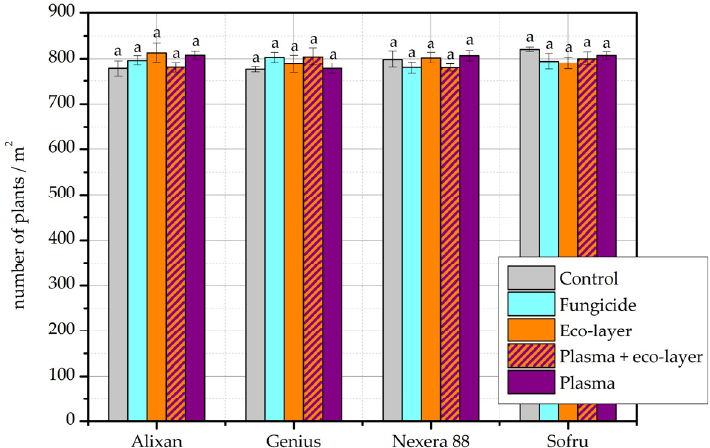
Figure 1. The number of emerged plants per m 2 according to individual treatments and cultivars in the year 2019/20. The error bars represent standard error. Different lowercase letters above data points represent statistically significant differences ( p < 0.05; post hoc Tukey’s range test) between treatments.